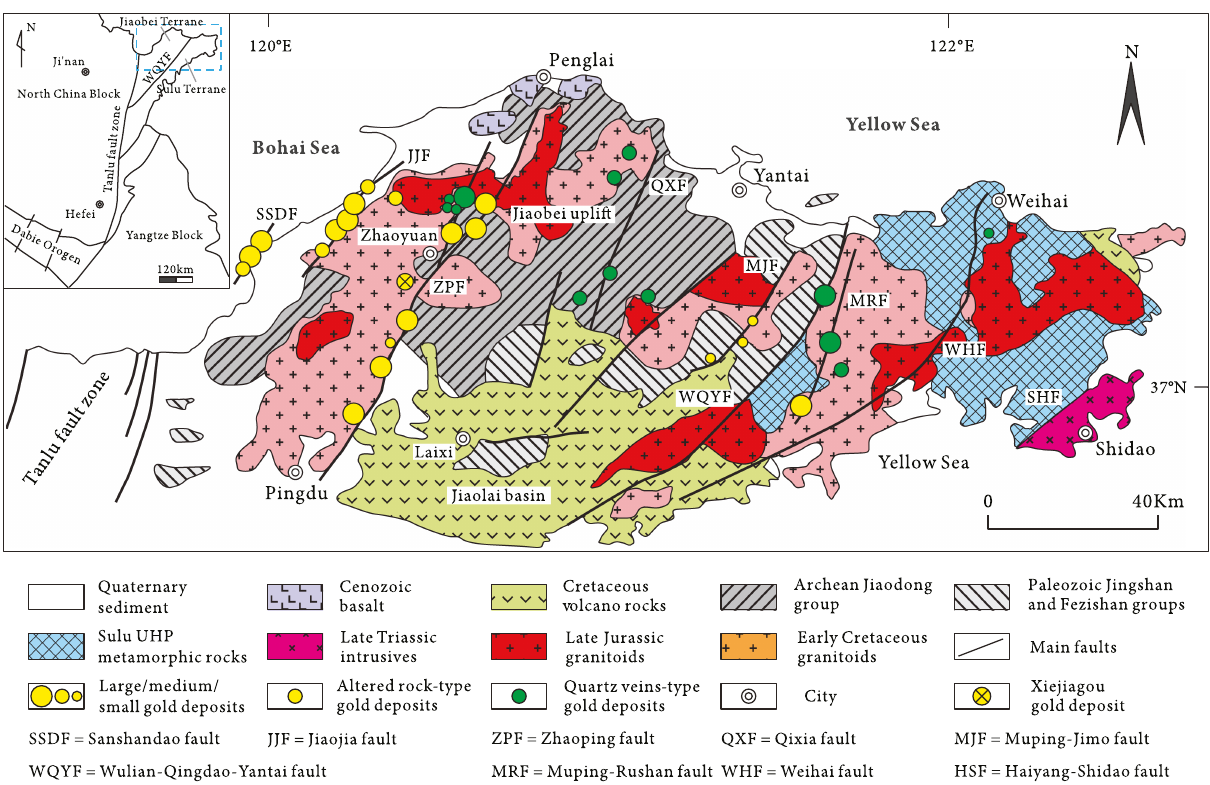
Figure 1: Geology of the Jiaodong gold province showing locations of large ( > 20 t Au), medium (5 – 20 t Au), and small ( < 5t Au) gold deposits (modi fi ed after Goldfarb and Santosh,